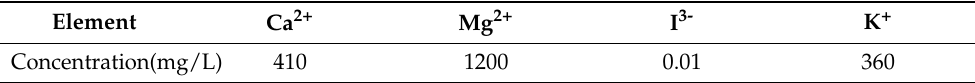
Table 2. Chemical composition of aluminum 1a90.